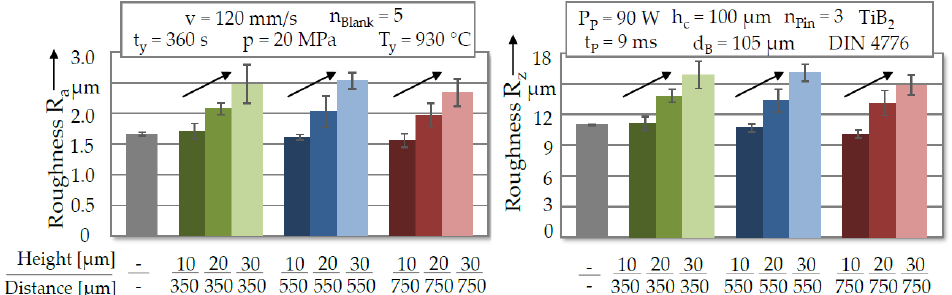
Figure 13. Tactile measurements of the worn blank topography according to the German Industrial Standard DIN 4476.